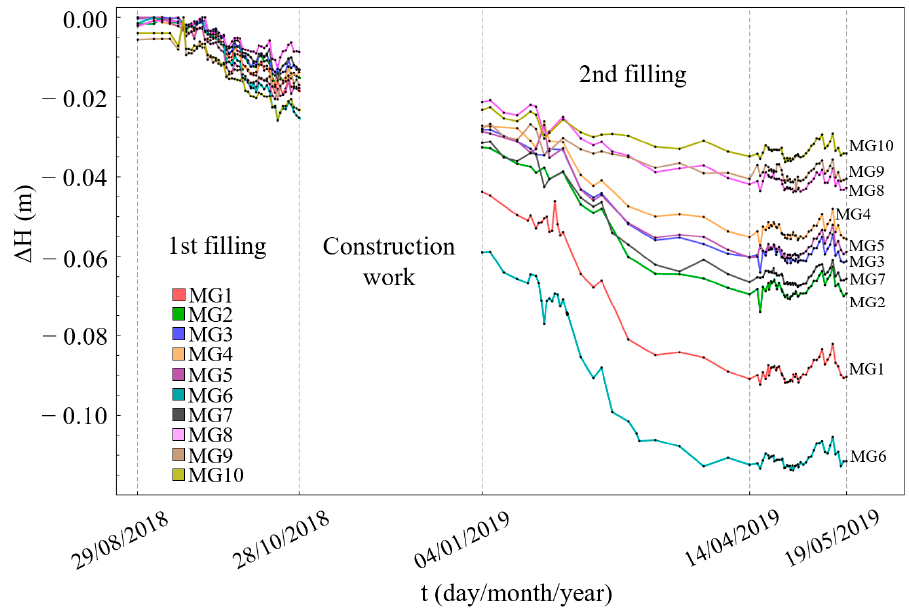
Figure 12. Settlement visualization of points MG1 to M10, from 29/08/2018 to 19/05/2019.